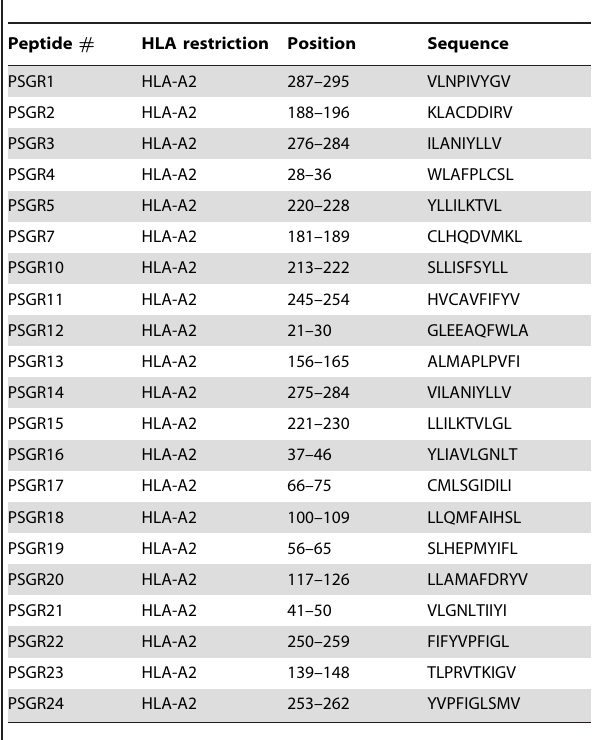
Table 1. The predicted HLA-A2 binding peptides